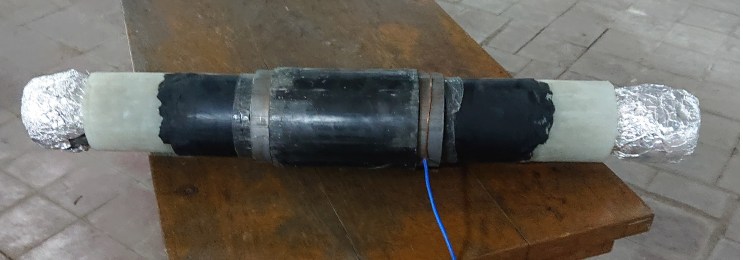
Figure 4. Conducting spherical terminations on each cable end is used to reduce the effect of corona